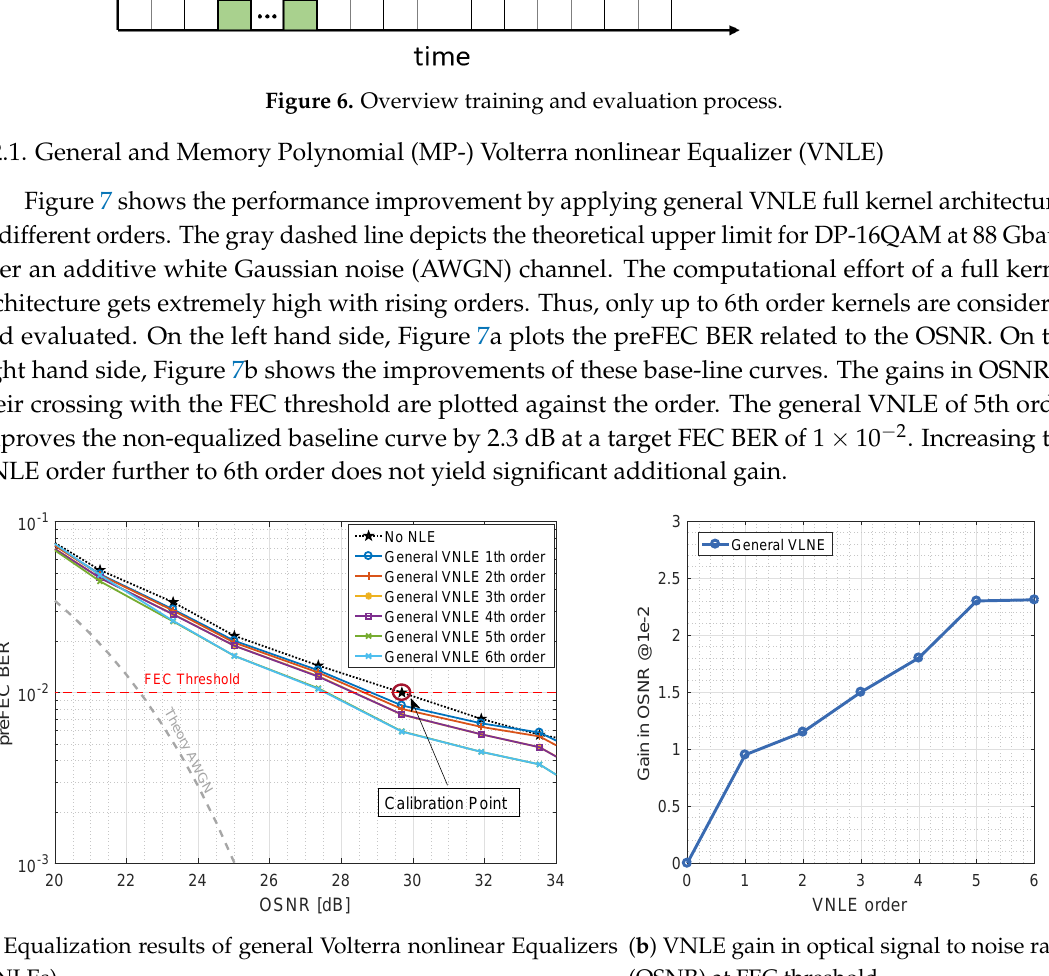
Figure 7. optical back-to-back 600 Gb/s/ λ general VNLE preFEC measurement